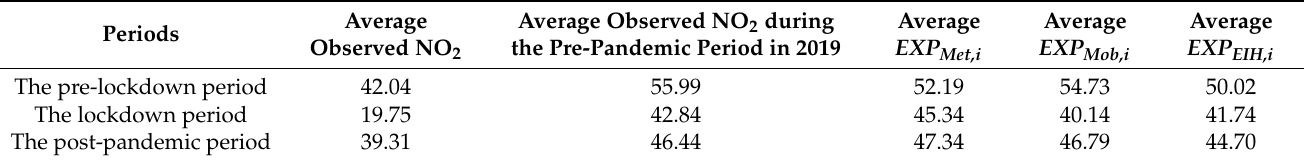
Table 6. The observed concentrations and the simulated results of sensitivity experiments (unit: µ g/m 3 ).